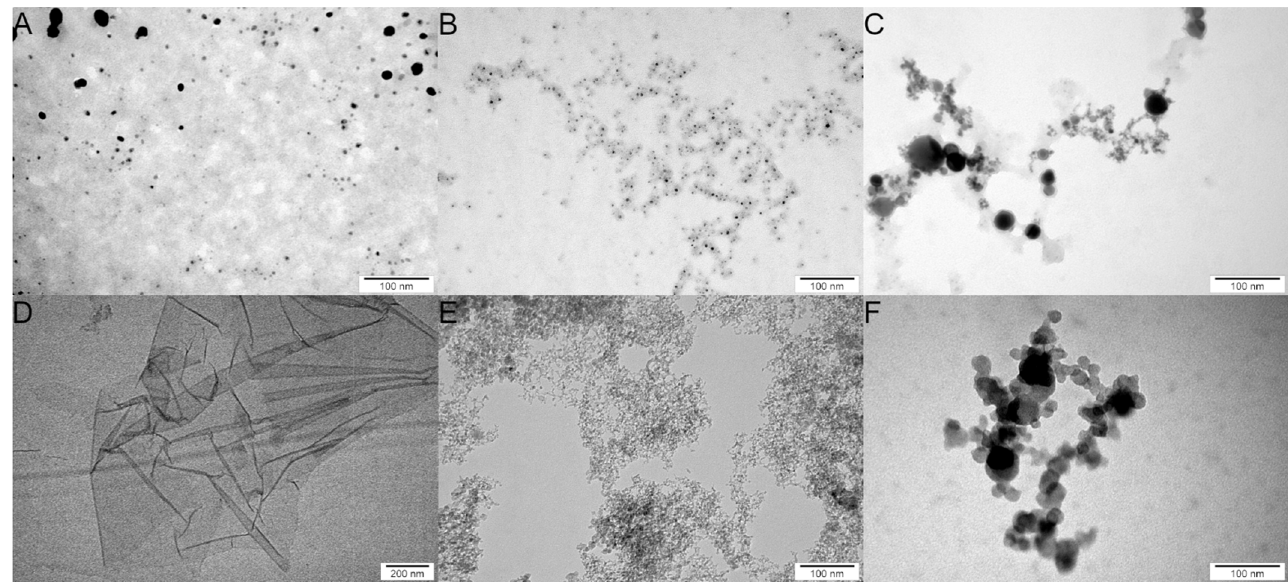
Figure 1. TEM imagines of the nanomaterials that were used in experiments. ( A ) silver (Ag); ( B ) gold (Au); ( C ) platinum (Pt); ( D ) graphene oxide (GO); ( E ) diamond (ND); and ( F ) fullerenol (C 60 (OH) 40 ).